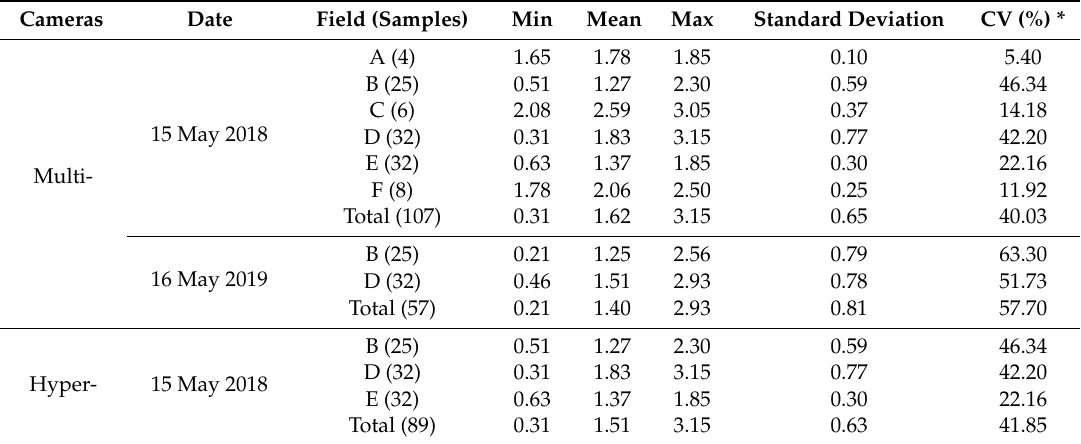
Table 4. Statistical summary of the in situ measured LAI (m 2 / m 2 ).